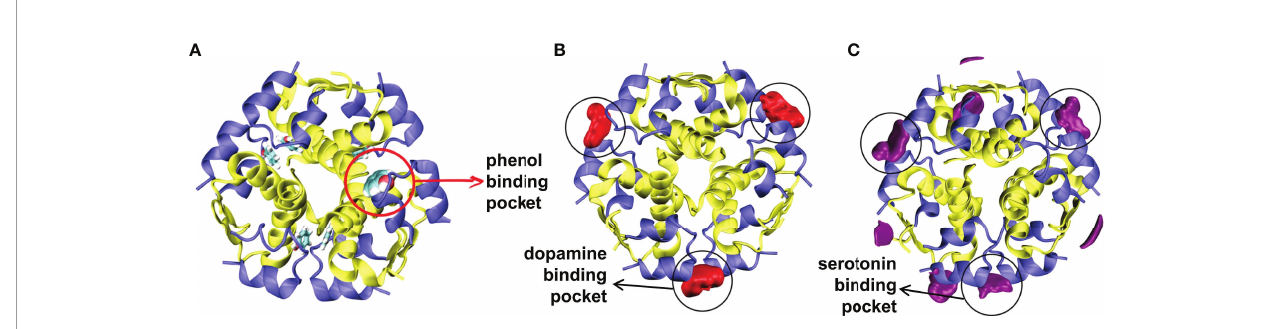
FIGURE 6 | Spatial distributions of neurotransmitters. (A) The starting conformation of the R 6 insulin hexamer with the phenol binding pocket is shown. Spatial distributions of (B) dopamine, and (C) serotonin around the insulin are depicted. Reprinted from Palivec et al. (52), an article published by Elsevier under the terms